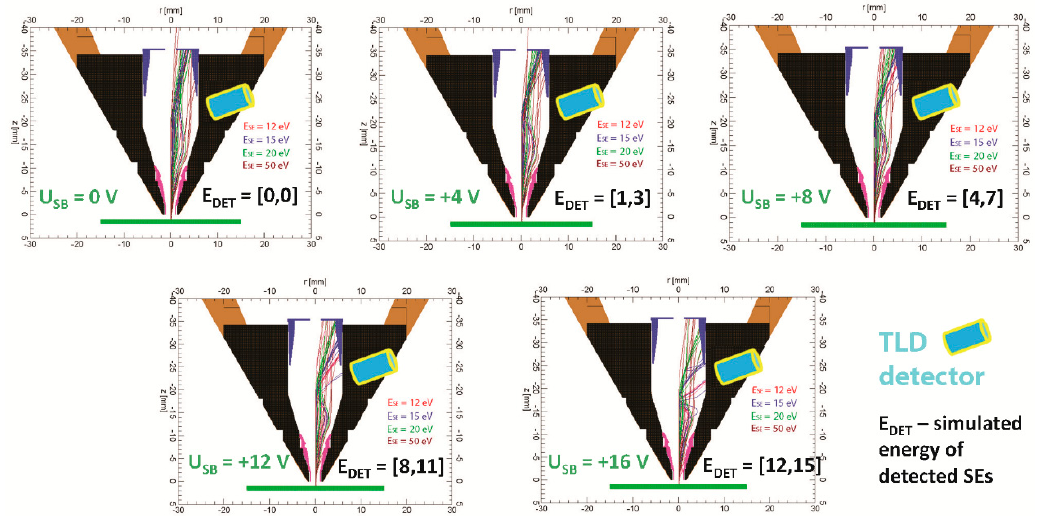
Figure 7. SE trajectories for energies E SE = 12, 15, 20, 50 eV, polar angle theta 0 = 0–90° with a step of 10°, azimuthal angle phi 0 = 0°, sample bias U SB = 0, +4, +8, +12, +16 V, E P = 1 keV, WD = 1 mm.